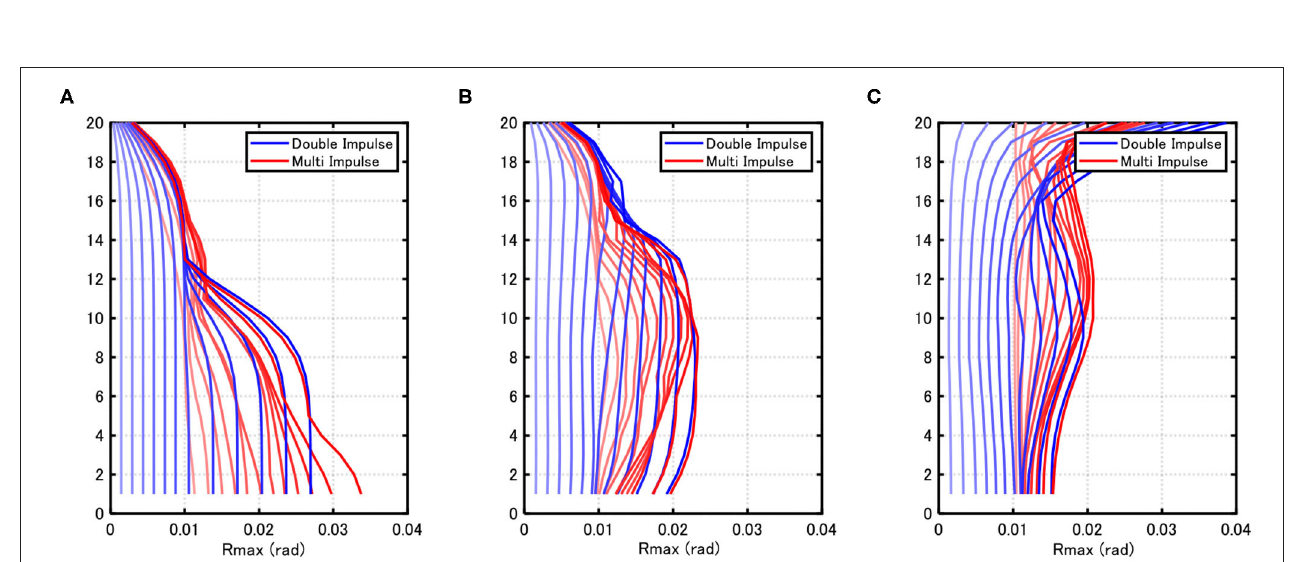
FIGURE 8 | Maximum interstory drift angle distribution by DIP and MIP ( V = 0.10–1.20 [ m / s ]). (A) Model 1, (B) Model 2, (C) Model 3.